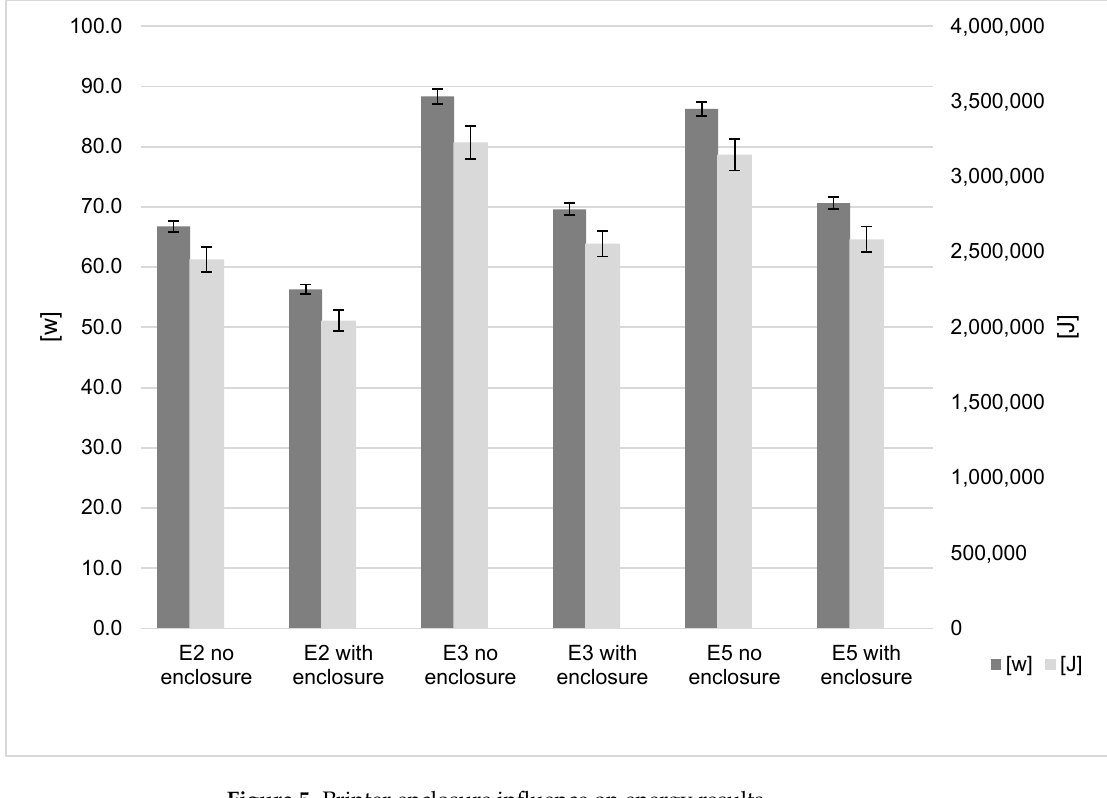
Figure 5. Printer enclosure influence on energy results.